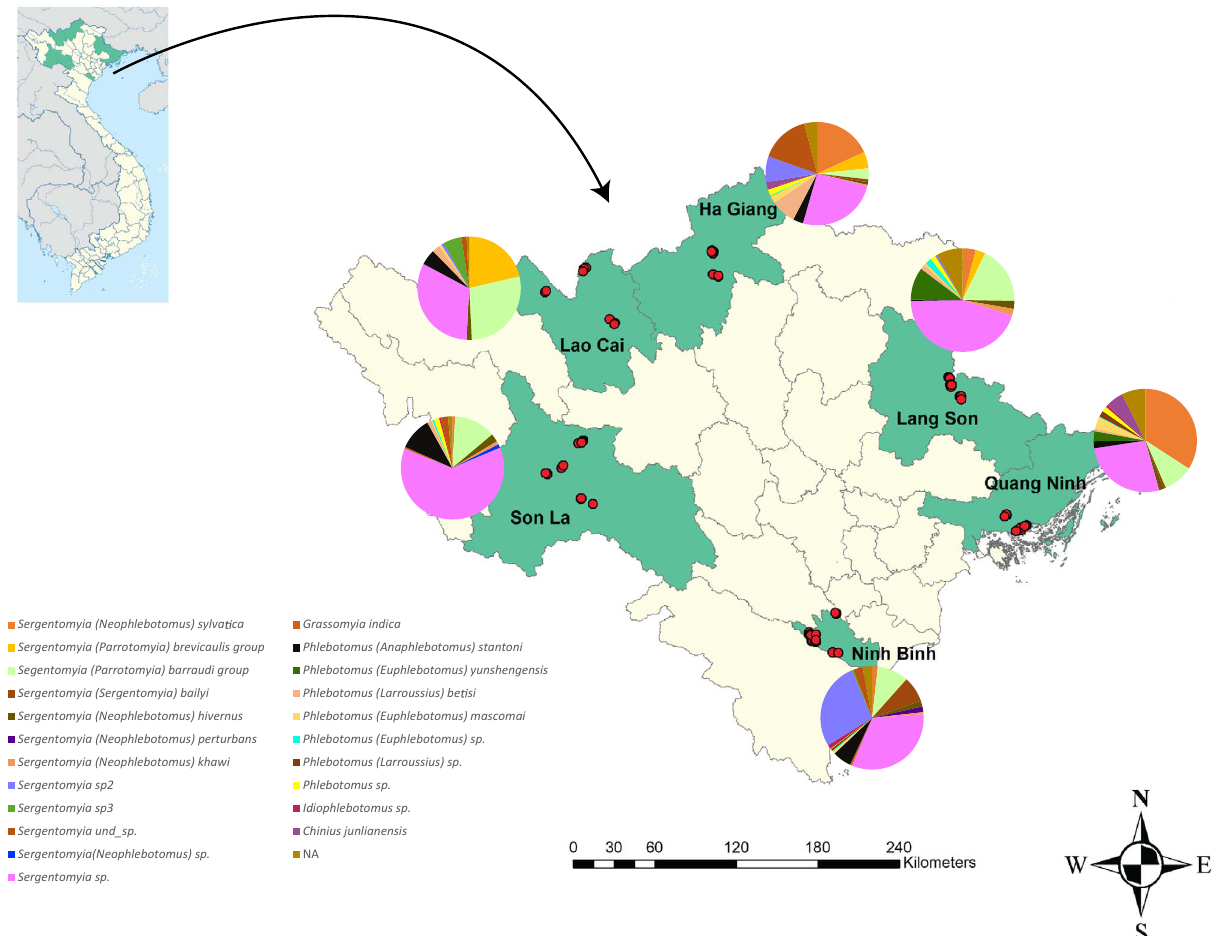
Figure 1. Collection sites and sand fl y species composition in 6 provinces of Northern